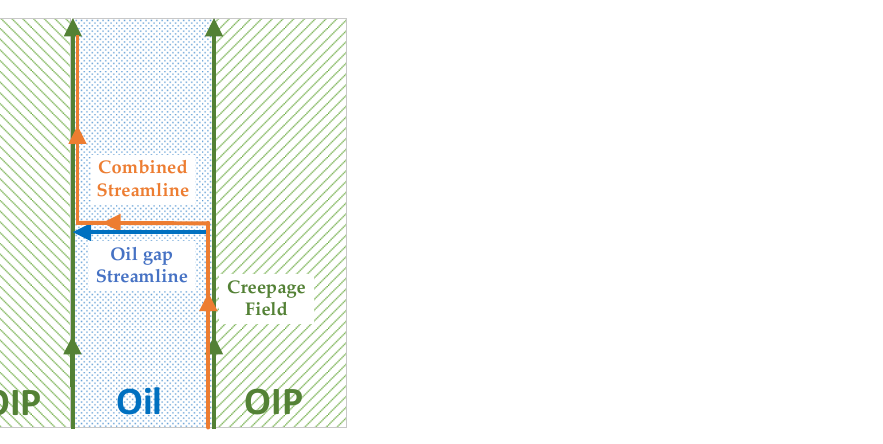
Figure 13. Extracting a combined path from an oil gap path and the linked creepage paths.